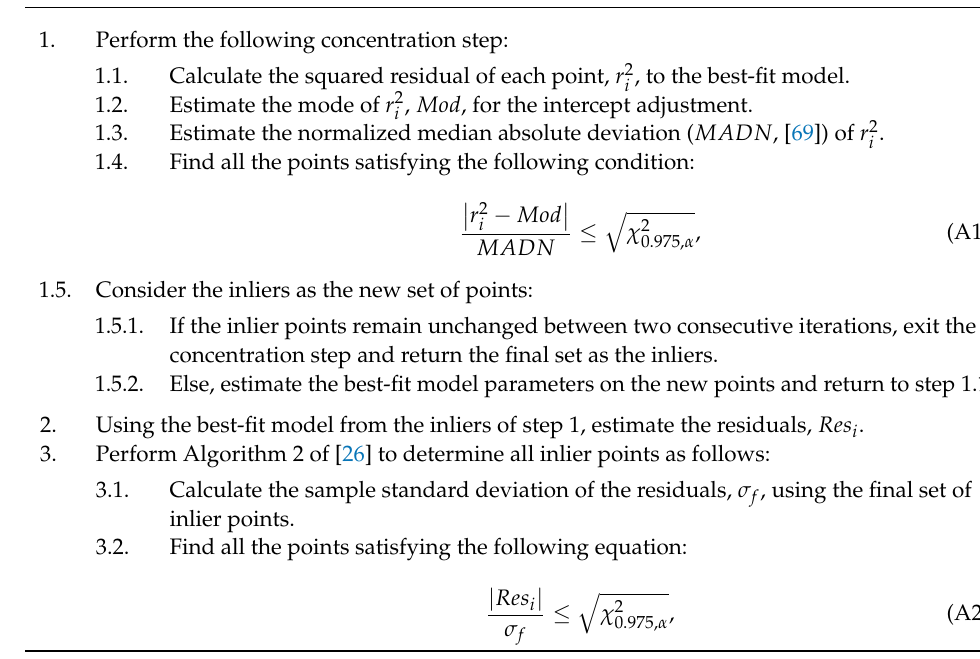
Algorithm A1 Robust Outlier Detection Given Parametric Surface